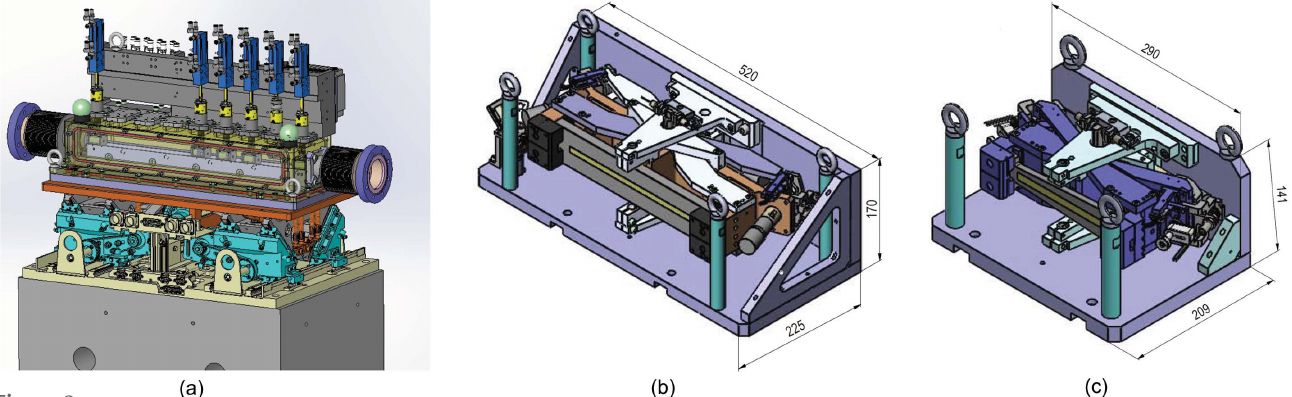
Figure 2 ( a ) Transfocator CAD-drawing. Pneumatic axes (blue) actuate the insertion of lens pack holders into the beam path and onto a high-precision V-rail for mutual lens pack alignment. Alignment (rotation and translation) of the transfocator is achieved through a Q-Sys motion platform (cyan). ( b ) Large- beam and ( c ) small-beam HFM assembly. The mirrors are shown in gray, with the illuminated region in yellow. Dimensions are given in millimetres.